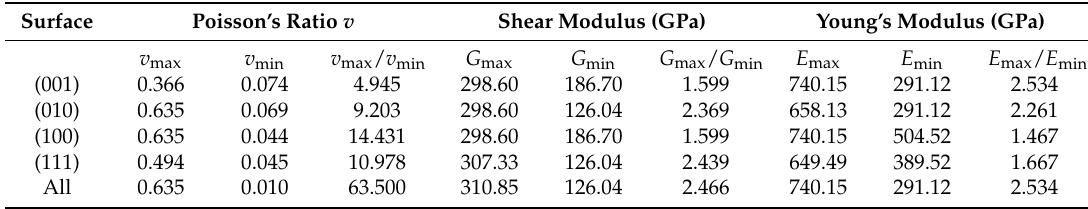
Table 3. The calculated the maximum and minimum values of Poisson’s ratio v , Shear modulus G , and Young’s modulus E for Pnma